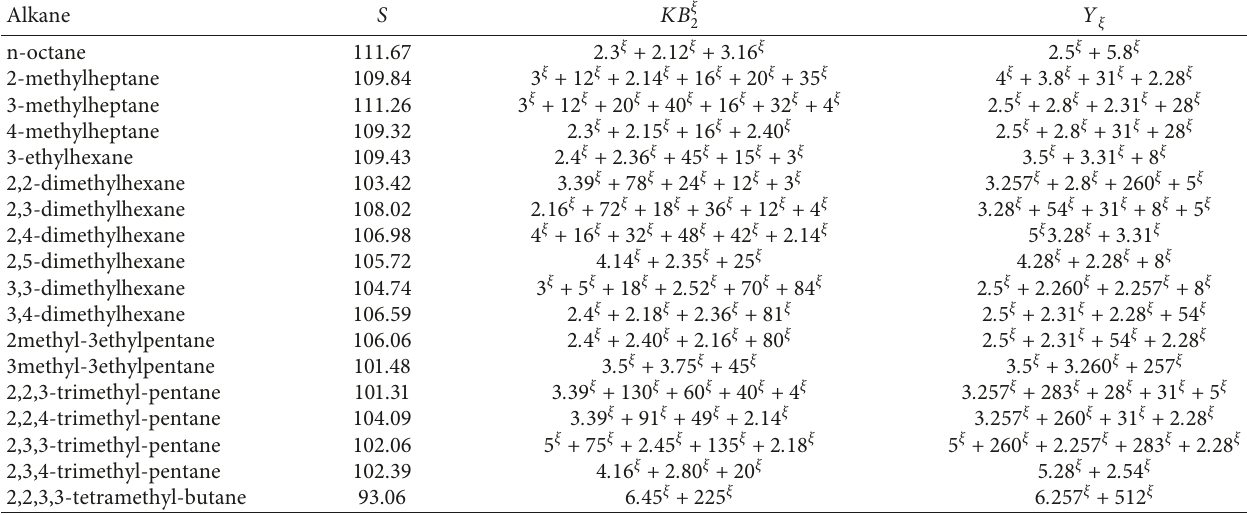
Table 7: Experimental values of entropy and the corresponding values of generalized form of second Kulli–Basava index and generalized power-sum-connectivity index of octane isomers.